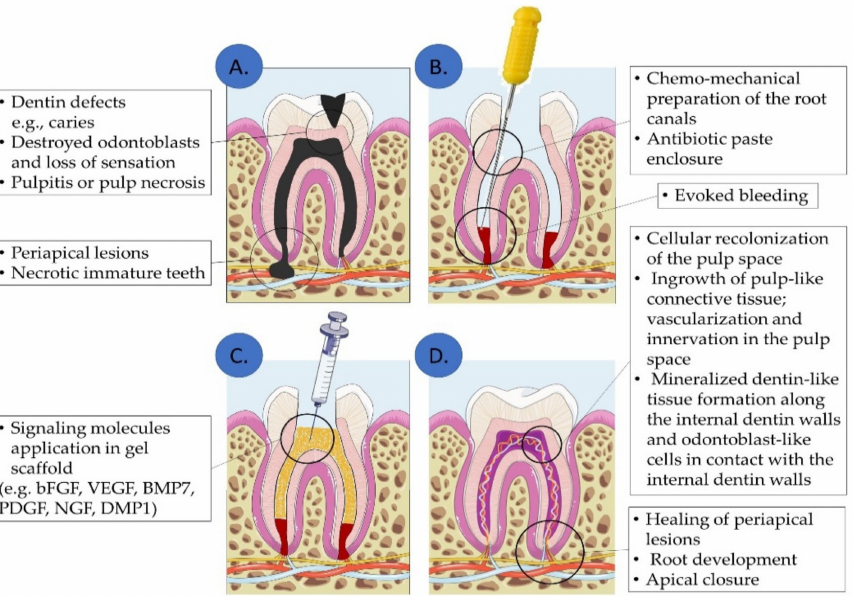
Figure 3. Dentin–pulp complex and pulp tissue regeneration approach by signaling molecules via cell homing: In dentin/pulp defects ( A ), the pulp chamber is chemomechanically prepared and disinfected and bleeding is evoked ( B ). Then, signaling biomolecules are applied into the root canals ( C ), leading to dentin-pulp complex and periapical tissue regeneration ( D ). (Illustration created using Servier Medical Art at